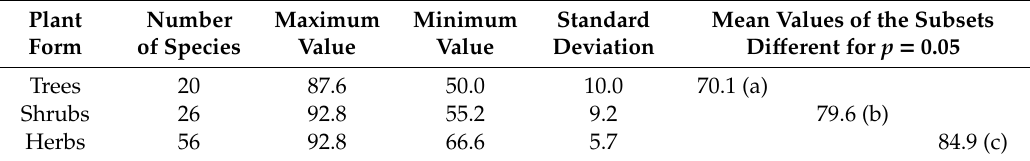
Table 1. Summary of J index values in the Malvaceae. Adapted from [42]. Mean values of the J index were compared by ANOVA (Sche ff é ’s test; IBM SPSS statistics v25) between three groups of species according to their life form (trees, shrubs, and herbs). Di ff erent letters indicate significant di ff erences at p = 0.05.